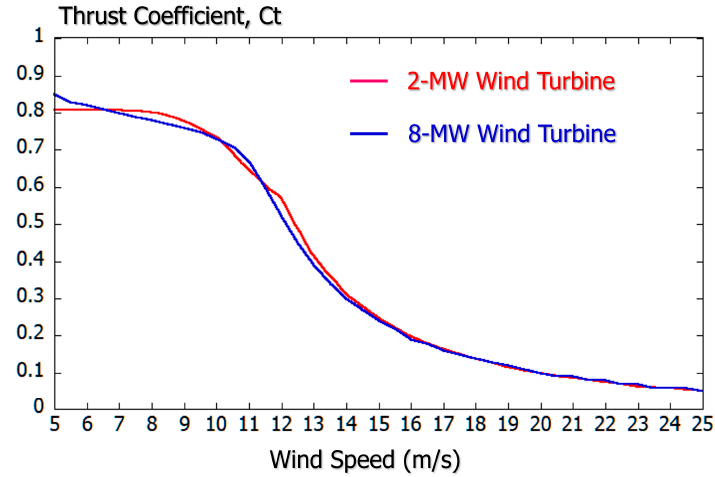
Figure 25. Relationship between the wind speed (horizontal axis) and the wind turbine thrust coefficient Ct (vertical axis) for various actual wind turbines [28,29].